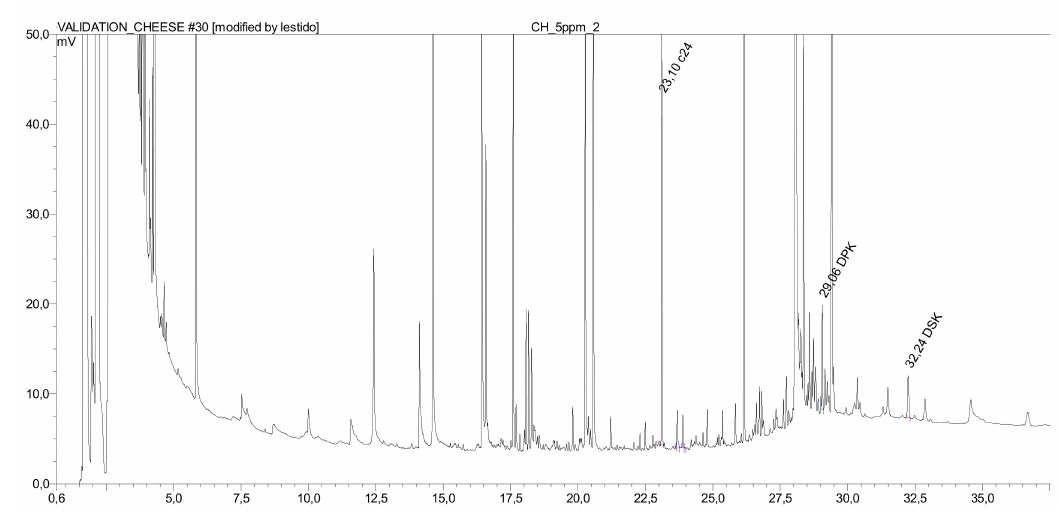
Figure 4. Gas chromatography coupled with flame ionization detection (GC-FID) chromatogram of the extract of cheddar cheese fat spiked with 5 µ g / g of dialkylketones: RT 23.10 min tetracosane (IS), RT 29.06 min palmitone, and RT 32.24 min stearone.